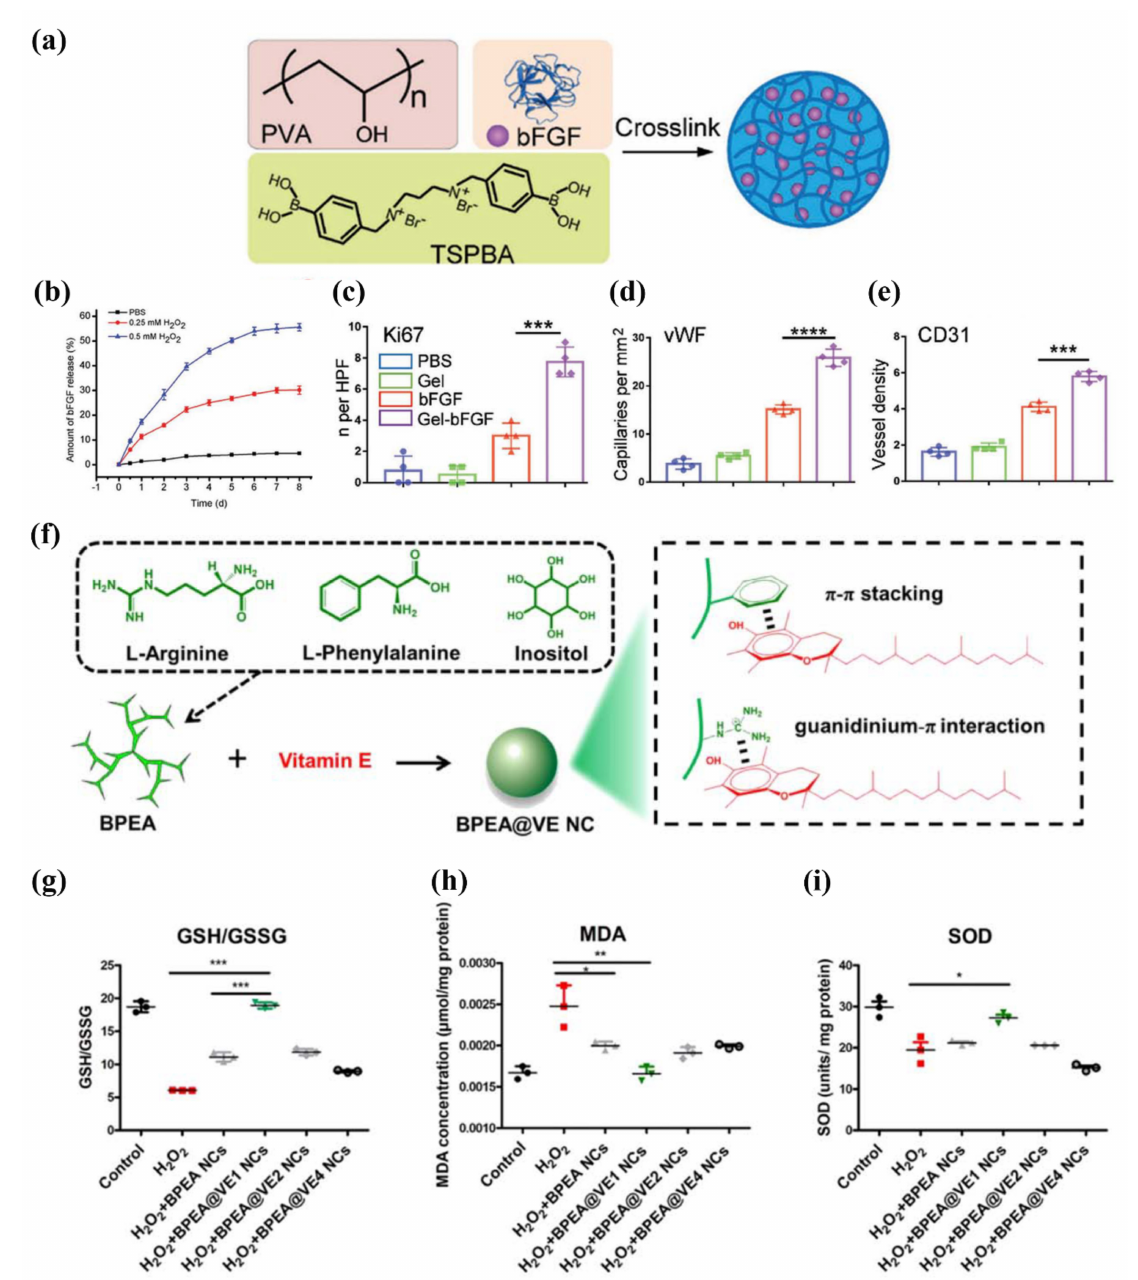
Figure 2. ( a ) Diagrammatic sketch of the preparation of bFGF loaded with PVA-TSPBA; ( b ) bFGF release behavior of bFGF loaded with PVA-TSPBA at various ROS concentrations. Quantitative data corresponding to Ki67 staining ( c ), vWF staining ( d ), and CD31 staining ( e ) (for statistical significance, *** p < 0.005 and **** p < 0.0001 ( c – e )); ( f ) schematic illustration of BPEA@VE